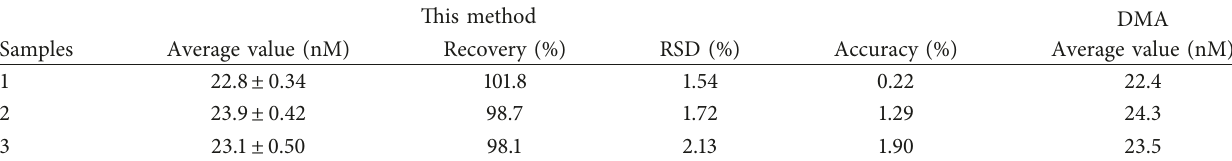
Table 2: Analytical results for the detection of Hg 2+ in real citrus leaf samples. This method